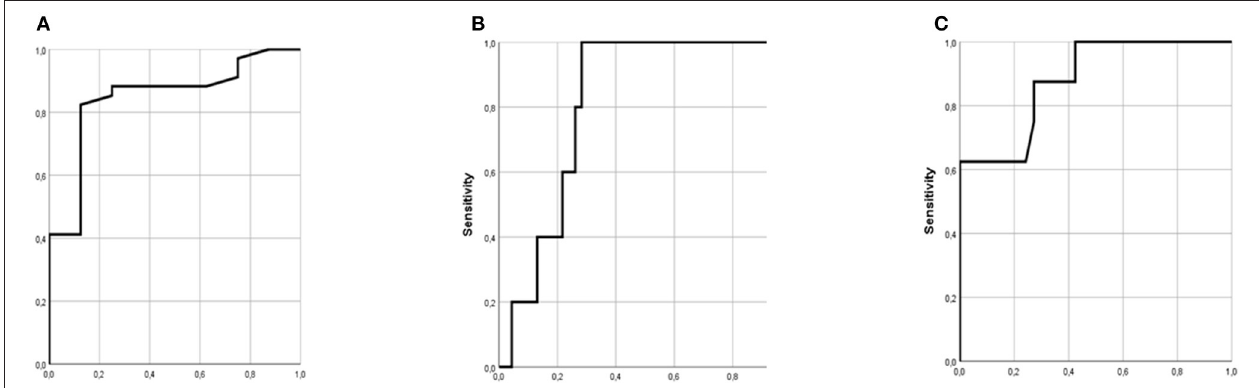
FIGURE 1 | ROC curves of variables predicting recurrence of vascular events during follow-up. (A) ROC of neutrophil antisedimentation rate (NAR) (Area: 0.847, p = 0.002, 95%CI: 0.703–0.992). (B) ROC of platelet function test based on impedance aggregometry in the upper blood sample (AUC upper ) after 1-h gravity sedimentation (Area: 0.813, p = 0.023, 95%CI: 0.689–0.937). (C) ROC of predicted probability of the combination of NAR and AUC upper (Area: 0.881, p = 0.001, 95%CI: